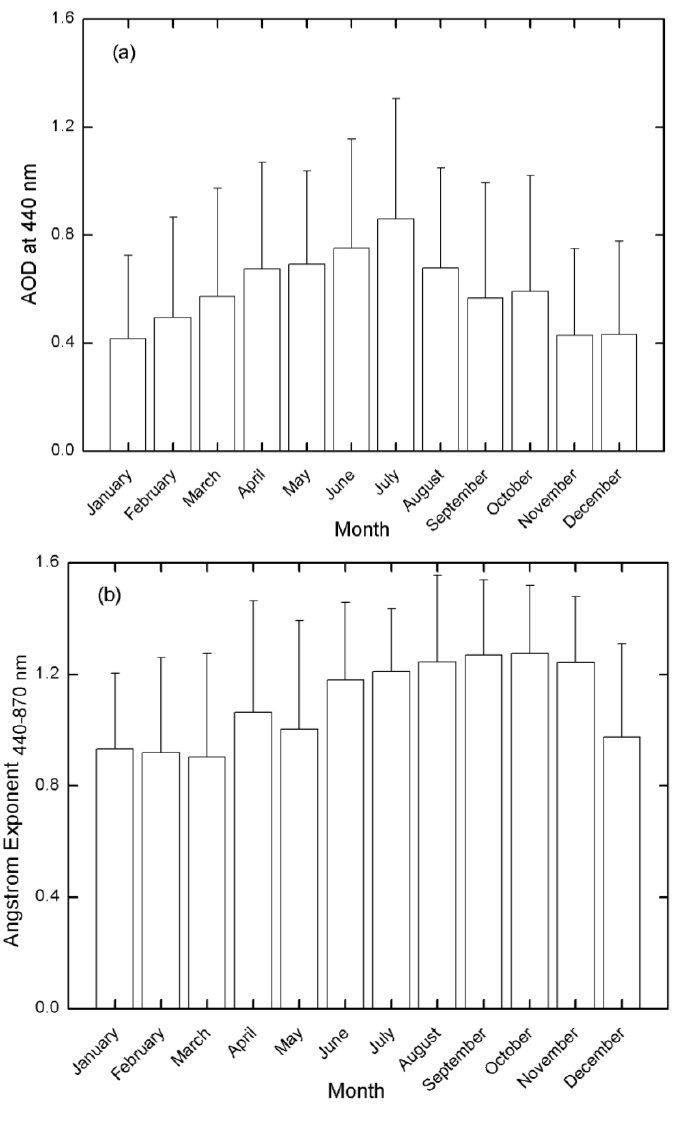
Figure 3. Monthly variations with mean ± SD in the ( a ) AOD 440nm and ( b ) Ångström exponent at Dalian monitoring station.